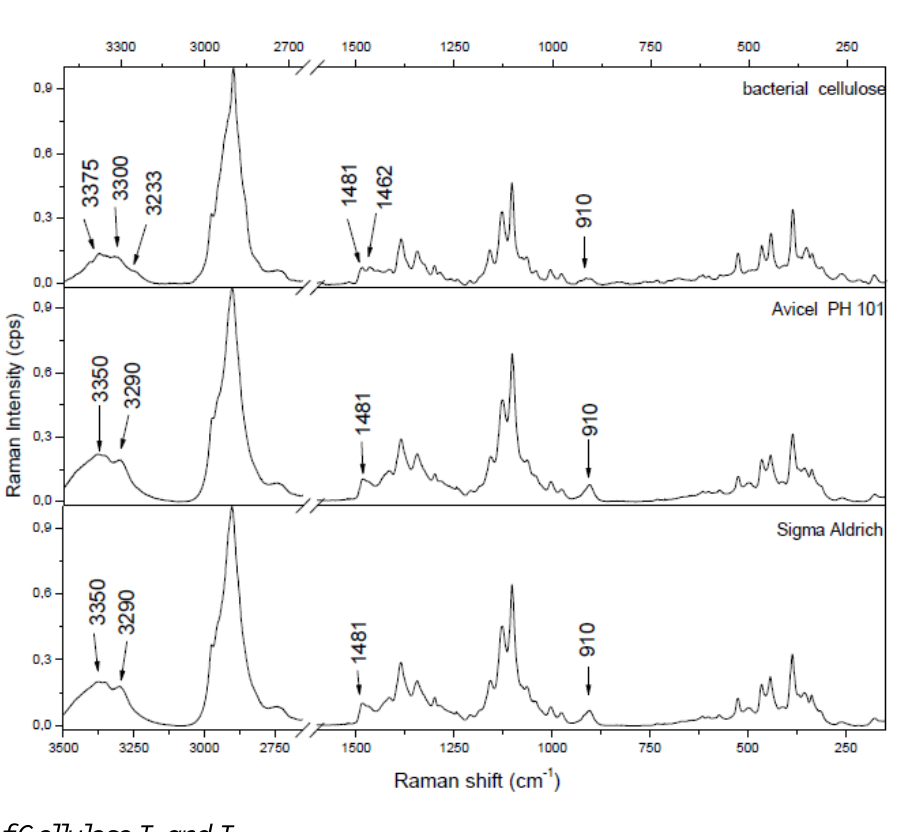
Figure 2. Comparison of bacterial cellulose and two microcrystalline celluloses (Aldrich and Avicel PH101). Raman spectra in the range 3,500–2,600 and 1,600–150 cm −1